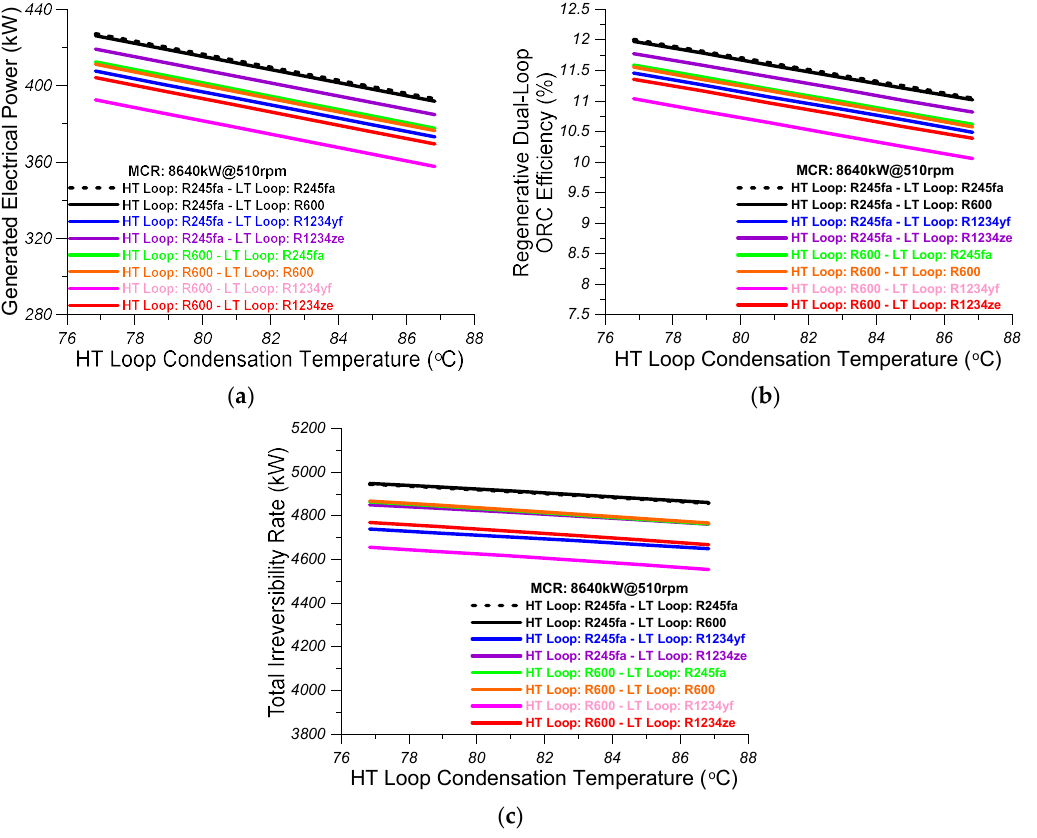
Figure 11. (a) Effect of the condensation temperature of the HT loop on the generated electric power of the regenerative dual-loop ORC; (b) Effect of the condensation temperature of the HT loop on the thermal efficiency of the regenerative dual-loop ORC; (c) Effect of the condensation temperature of the HT loop on the total irreversibility rate of the regenerative dual-loop ORC. Results are given for all the pairs of organic mediums that are examined in the present study.